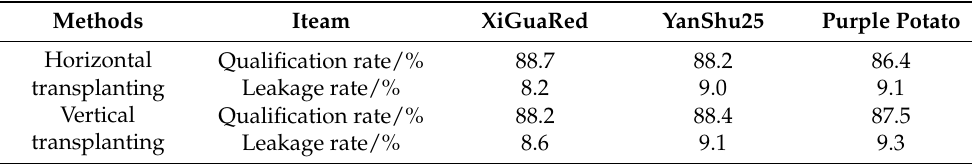
Table 7. Replanting